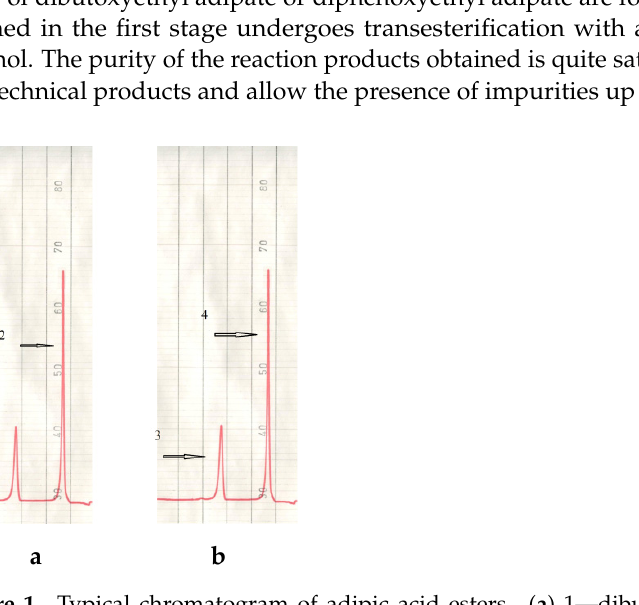
Figure 3. FTIR spectra of decyl phenoxyethyl adipate. In addition, in the IR spectra of esters, in contrast to acids, there is no very broad (“acidic”) band in the range of 3500–2500 cm − 1 with a number of small peaks, and the band of bending vibrations of the CH 3 group at about 1360 cm − 1 is clearly manifested. In acids, this band is very weak. Stretching vibrations of the C–O group in the IR spectra of esters, as well as in the spectra of acids and alcohols, give a number of strong bands in the range of 1300–1000 cm − 1 , but they are not characteristic. Nevertheless, it is possible to distinguish the average vibration frequencies ν (C–O) for a number of esters with a hydrocarbon chain. The strongest peak is observed at about 1139 cm − 1 for DPEA and 1157 cm − 1 for DBEA. In addition to it, esters of such acids have two more weaker bands associated with C–O vibrations: peaks at about 1243 cm − 1 and 1285 cm − 1 for DBEA; about 1255 cm − 1 and 1242 cm − 1 for DPEA. The presence of an aromatic substituent in the DPEA ether manifests itself in the IR spectra as peaks at 1597 cm − 1 and 1497 cm − 1 , corresponding to the vibrations of the C–C bond.